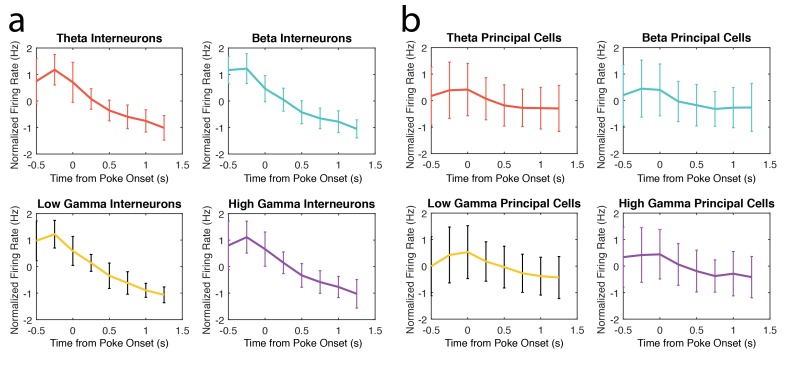
DOI:
http://dx.doi.org/10.7554/eLife.09849.021